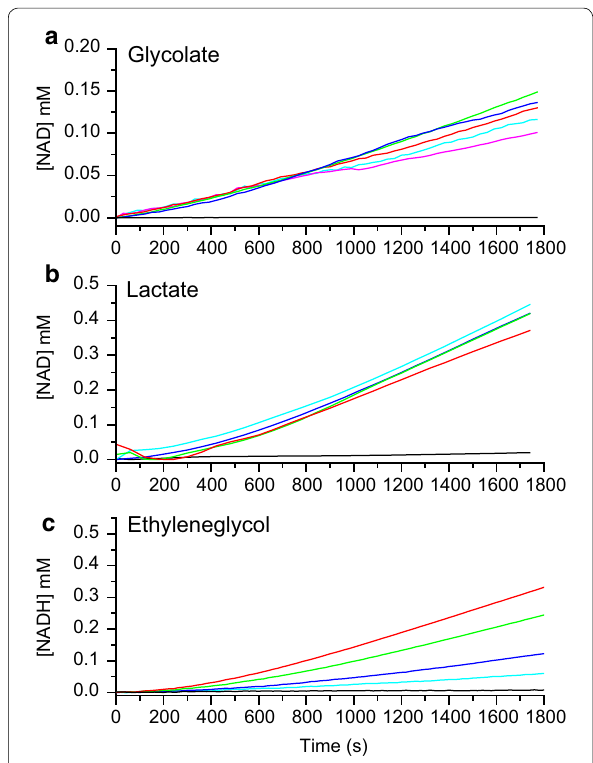
Fig. 4 Evaluation of in vitro enzyme pathways for production of glycolate ( a ), lactate ( b ), and ethyleneglycol ( c ) (see also Fig. 1). In each case, the substrate for the pathway was xylonolactone and the pathway was composed of 4 enzymes, where the first three enzymes are common and the 4th is varied depending on the desired product. The production of glycolate was followed through generation of NADH, the production of lactate through generation of NADH, and the production of ethylene glycol was followed through generation of NAD + by the final enzymatic step catalysed by Ec AldA ( a ), LDH ( b ), and Ec FucO ( c ) respectively. The reaction conducted at 22 °C contained 50 mM Tris HCl pH 7.0, 10 mM MgCl 2 , 0.5 mM DTT, 2 mM NAD + or NADH, 1 mM xylonolactone, 4 µg Cc XylC, 2 µg Cc XylD, 2 µg Ec YagE. In a the amount of Ec AldA was varied 0 µg (black line), 2 µg (magenta line), 4 µg (cyan line), 8 µg (blue line), 16 µg (green line) and 24 µg (red line). In b the amount of LDH was varied 0 µg (black line), 0.1 µg (cyan line), 0.2 µg (blue line), 0.4 µg (green line), 0.8 µg (red line). In c the amount of Ec FucO was varied 0 µg (black line), 1 µg (cyan line), 2 µg (blue line), 4 µg (green line), 8 µg (red